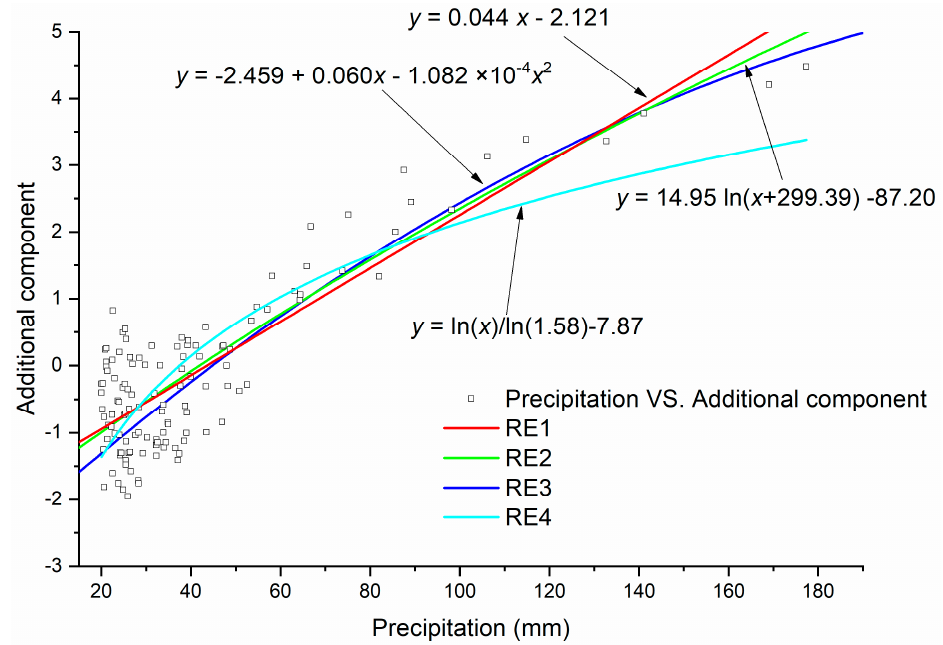
Figure 3. Regression models that describe the relation of additional component to rainfall intensify (daily rainfall depth).